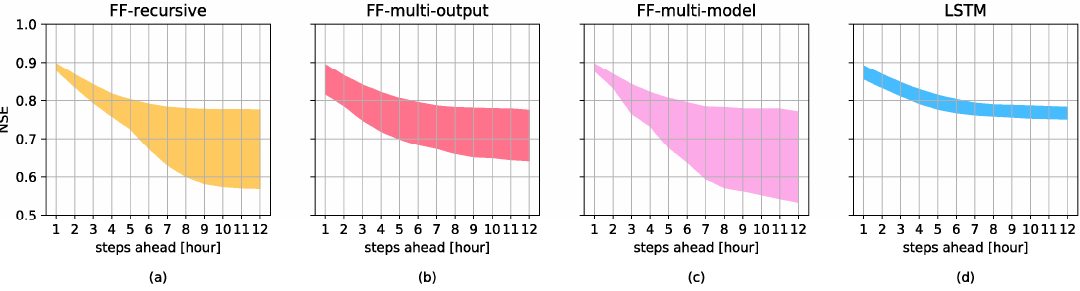
Figure 9. Sensitivity bands obtained with FF-recursive ( a ), FF-multi-output ( b ), FF-multi-model ( c ), and LSTM ( d ) on the 12-step-ahead prediction. Values refer to the test year